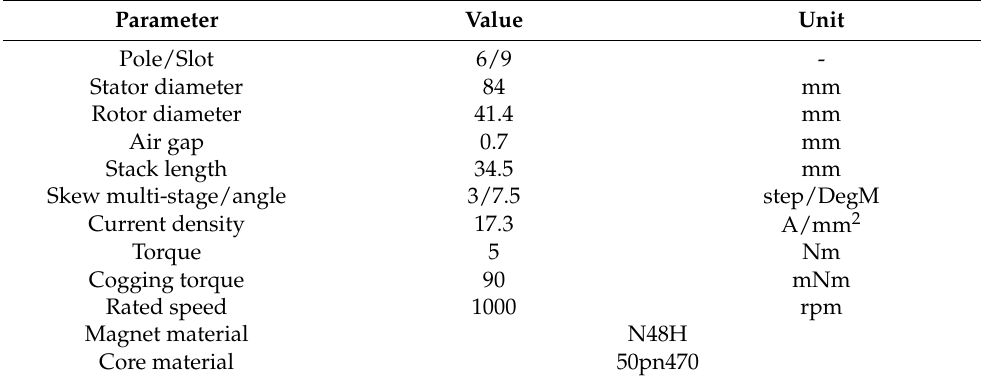
Figure 1. Existing model for EPS: ( a ) full model, ( b ) 3-stage skew rotor 2. Applying consequent poles to reduce the use of magnets. Table 1. Performance and Specifications of Existing Models.